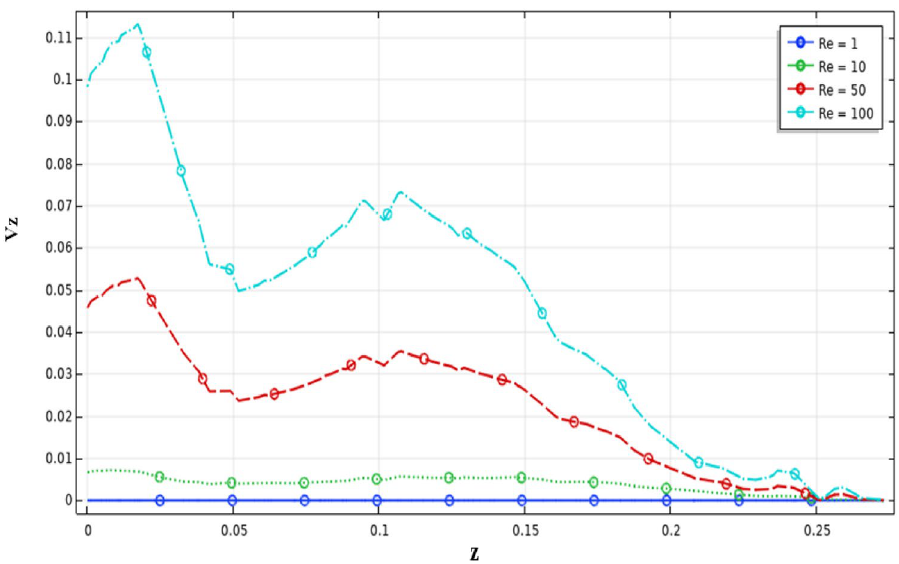
Figure 11. Velocity distribution in the vertical section Vz on the stirred tank for different Reynolds numbers.